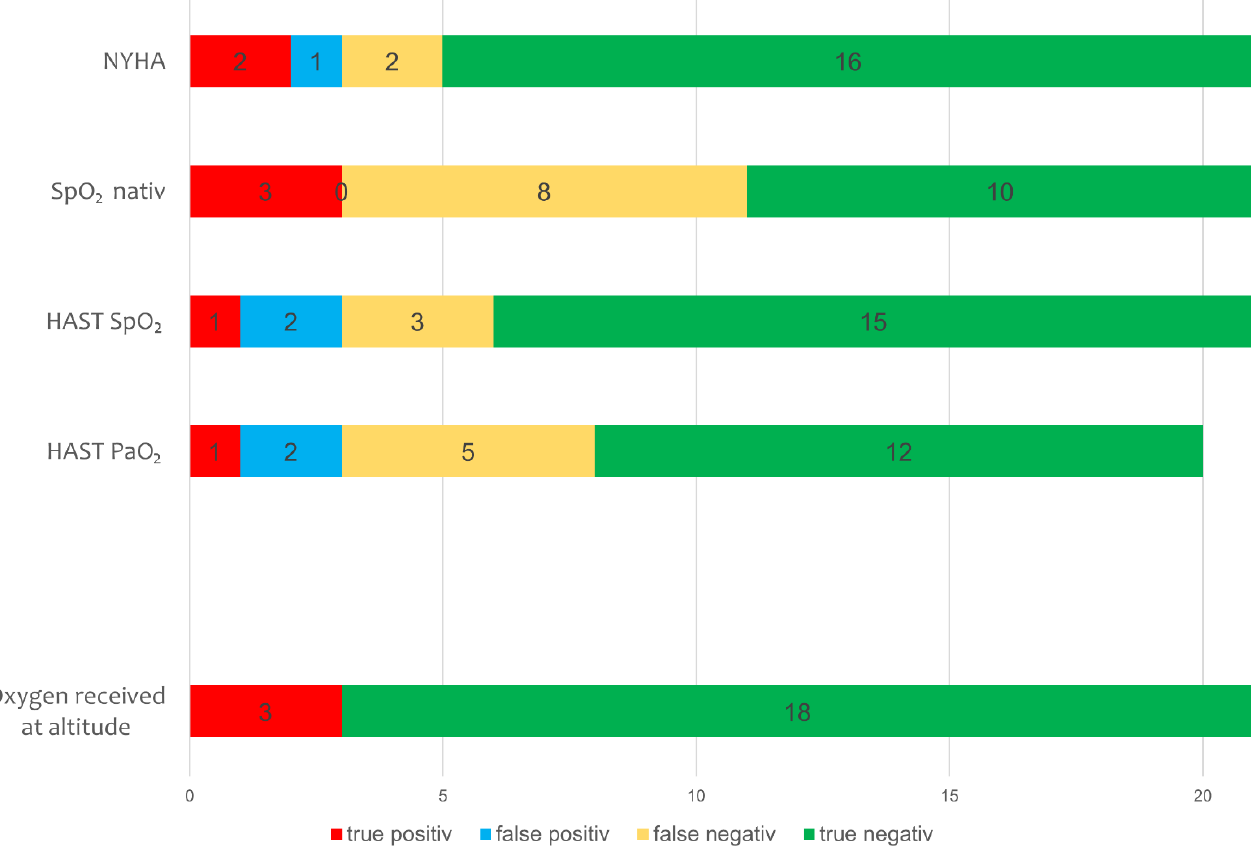
Figure 4. Predictions for oxygen at altitude. NYHA = New York Heart Association class, HAST = High altitude simulation test, numbers in bar represent absolute numbers. PaO 2 (n = 20).